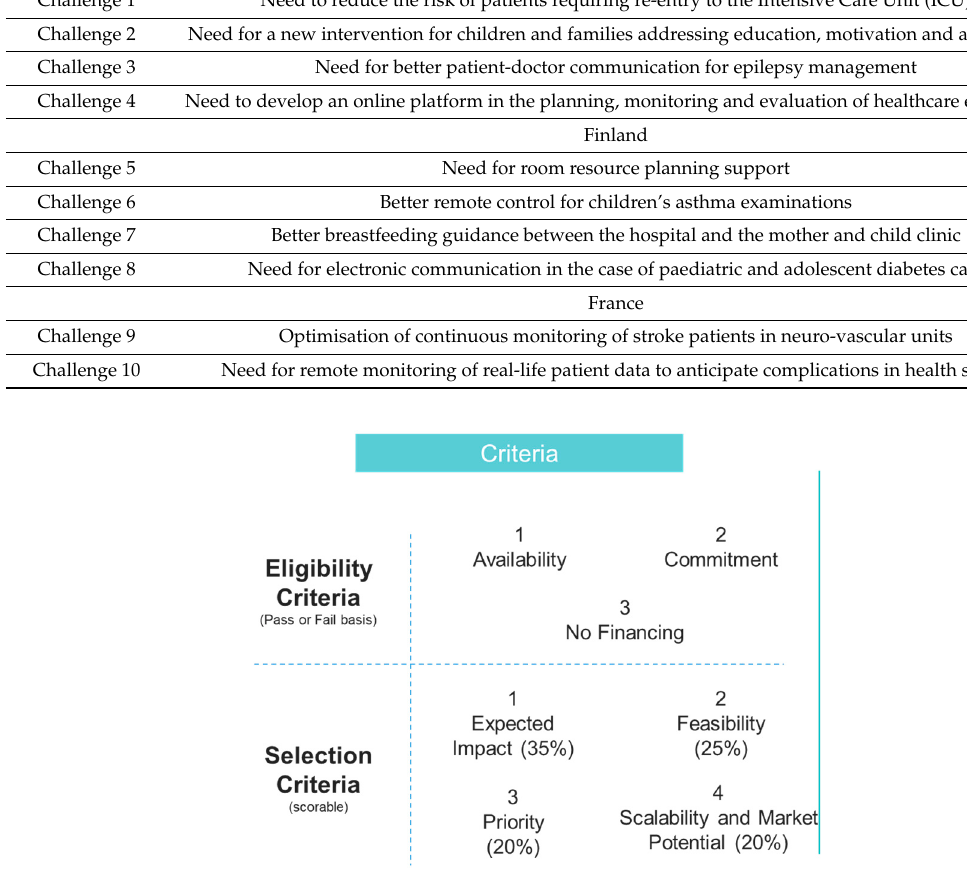
Figure 2. Selection criteria.